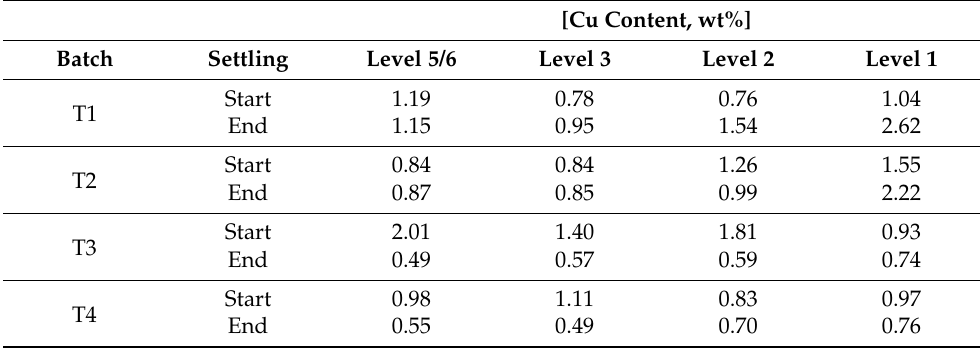
Table 4. The copper content in vertical slag samples of batch T1–T4, collected at the settling start and end. The complete compositions of the samples are found in Table